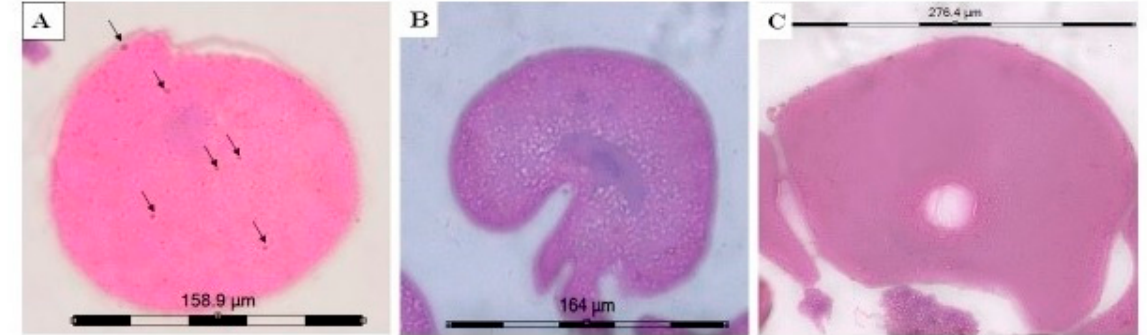
Figure 3. Microphotograph of immunoperoxidase labelling with anti-PGES in R. annulatus tick ovaries. ( A ): Oocyte of ovary of control tick showing intact membrane, yolk droplets and cytoplasm; Arrows indicates the presence of PGES enzymes; ( B ): Oocyte of ovary of tick treated with flumethrin (90 ppm) showing irregular shaped oocyte and disrupted yolk droplets with no localization of PGES; ( C ): Oocyte of ovary of tick treated with terpenoid subfraction of A. nilagirica (40%) showing degeneration of nuclear region and disrupted yolk granules with no localization of PGES.